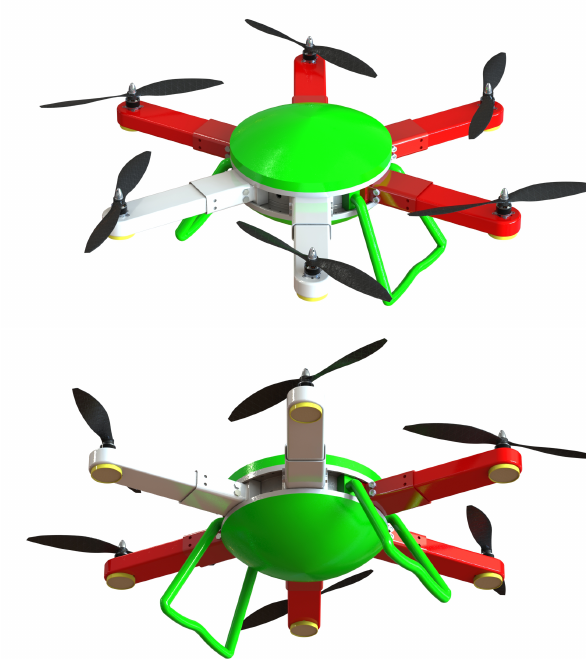
Figure 1: Top and bottom view of the classic exacopter configura-